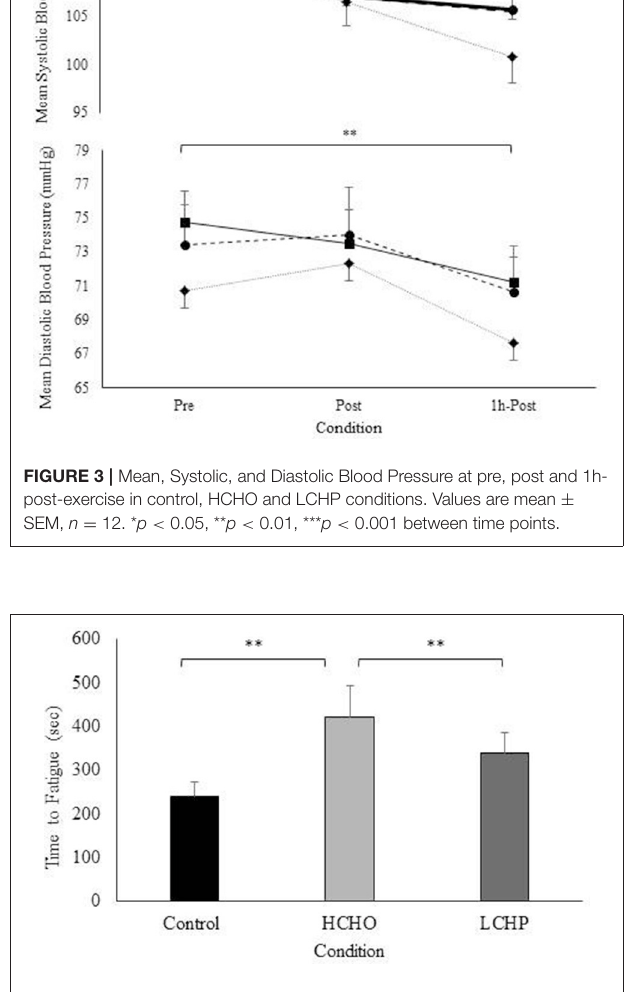
FIGURE 4 | Average time in seconds to volitional cessation of exercise in control (fasted), HCHO (high carbohydrates breakfast and beverage), and LCHP (low carbohydrates-high protein- breakfast and whey protein beverage) conditions. Values are mean ± SEM, n = 12. ** p <